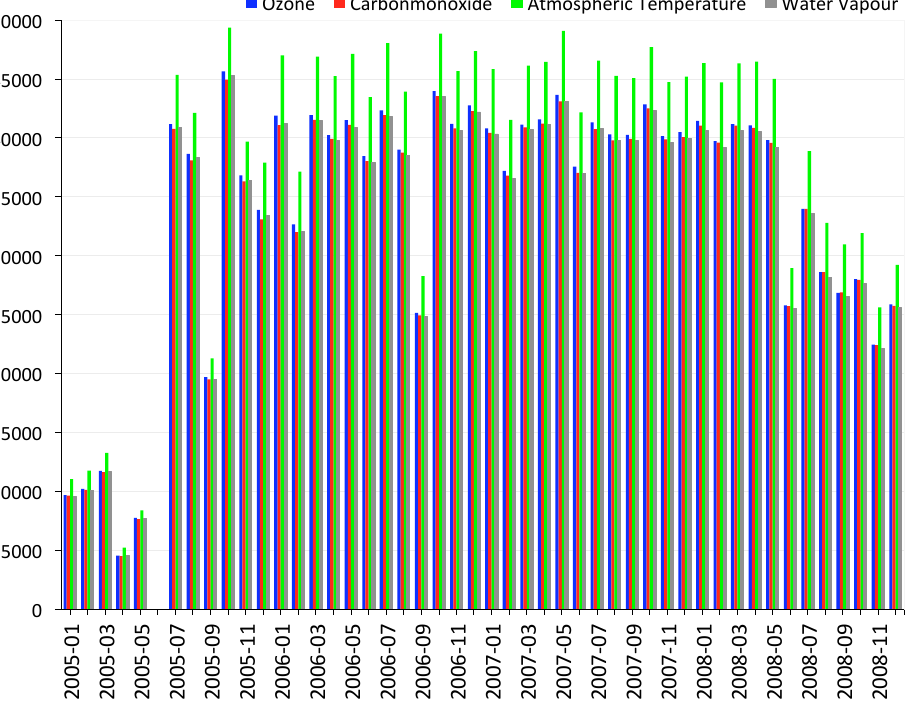
Fig. 5. The total number of good nadir points sampled by TES in 2005 through 2008 for ozone, carbon monoxide, temperature and water vapour. TES conducts no measurement in June 2005.